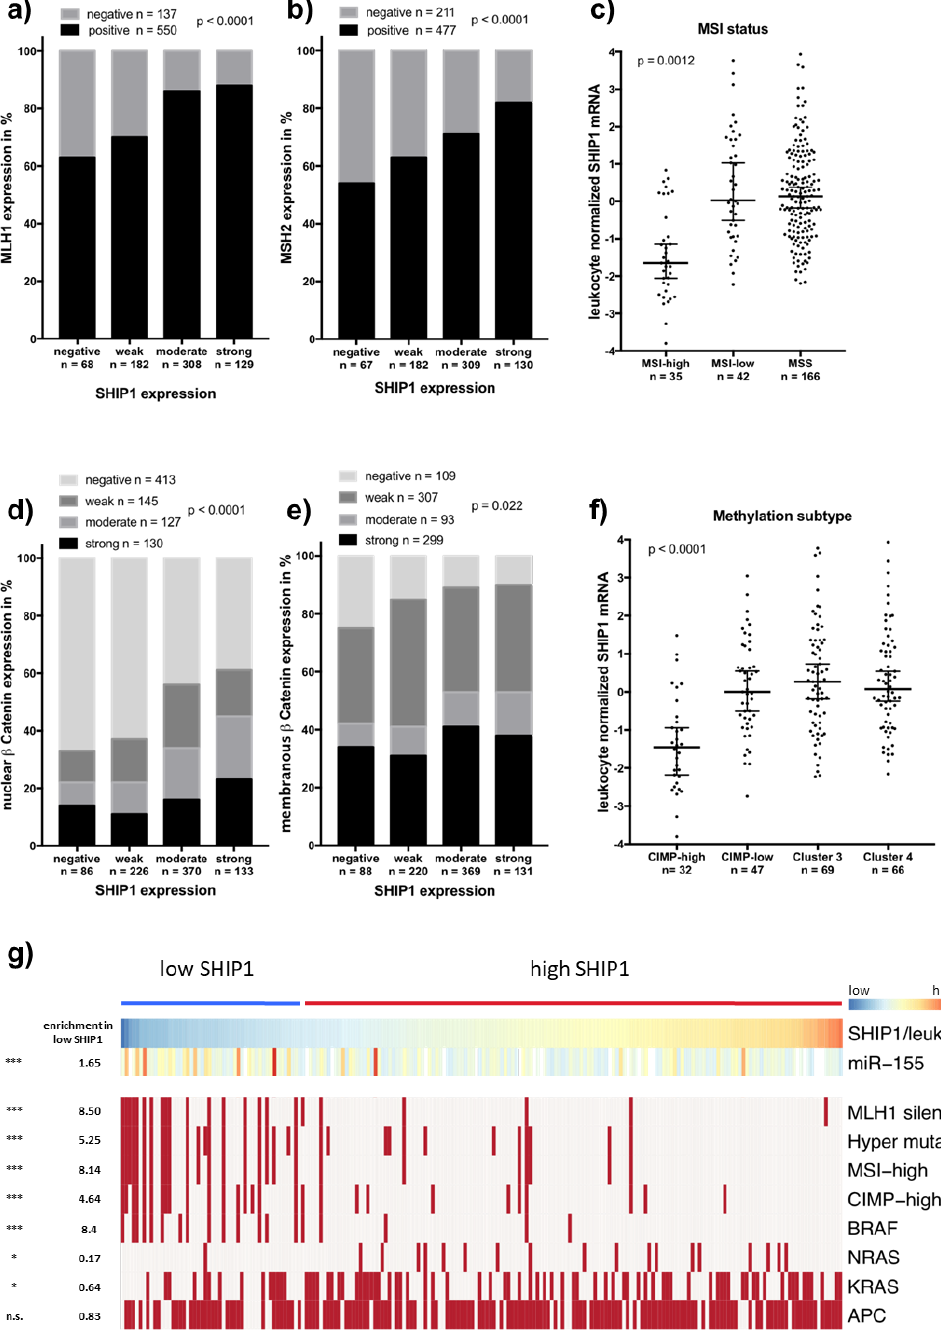
Figure 4. The absence of SHIP1 expression in colorectal cancer is linked to microsatellite instability. ( a , b ) Immunohistochemistry-scored SHIP1 expression was correlated with expression of MLH1 and MSH2 as markers for microsatellite instability ( p > 0.0001, each). ( c ) Leukocyte normalized SHIP1 mRNA expression from TCGA was analyzed for association with microsatellite status ( p = 0.0012). ( d , e ) Immunohistochemistry-scored SHIP1 expression was correlated with the expression of nuclear and membranous β-Catenin ( p > 0.0001 and p = 0.0022, respectively). ( f ) Leukocyte normalized SHIP1 mRNA expression was analyzed for association with methylation subtypes ( p < 0.0001). ( g ) Leukocyte normalized SHIP1 mRNA expression was classified into low SHIP1 expression (low quartile) and high (upper three quartiles), and hierarchical clustering was performed, showing enrichment of microsatellite instability markers.